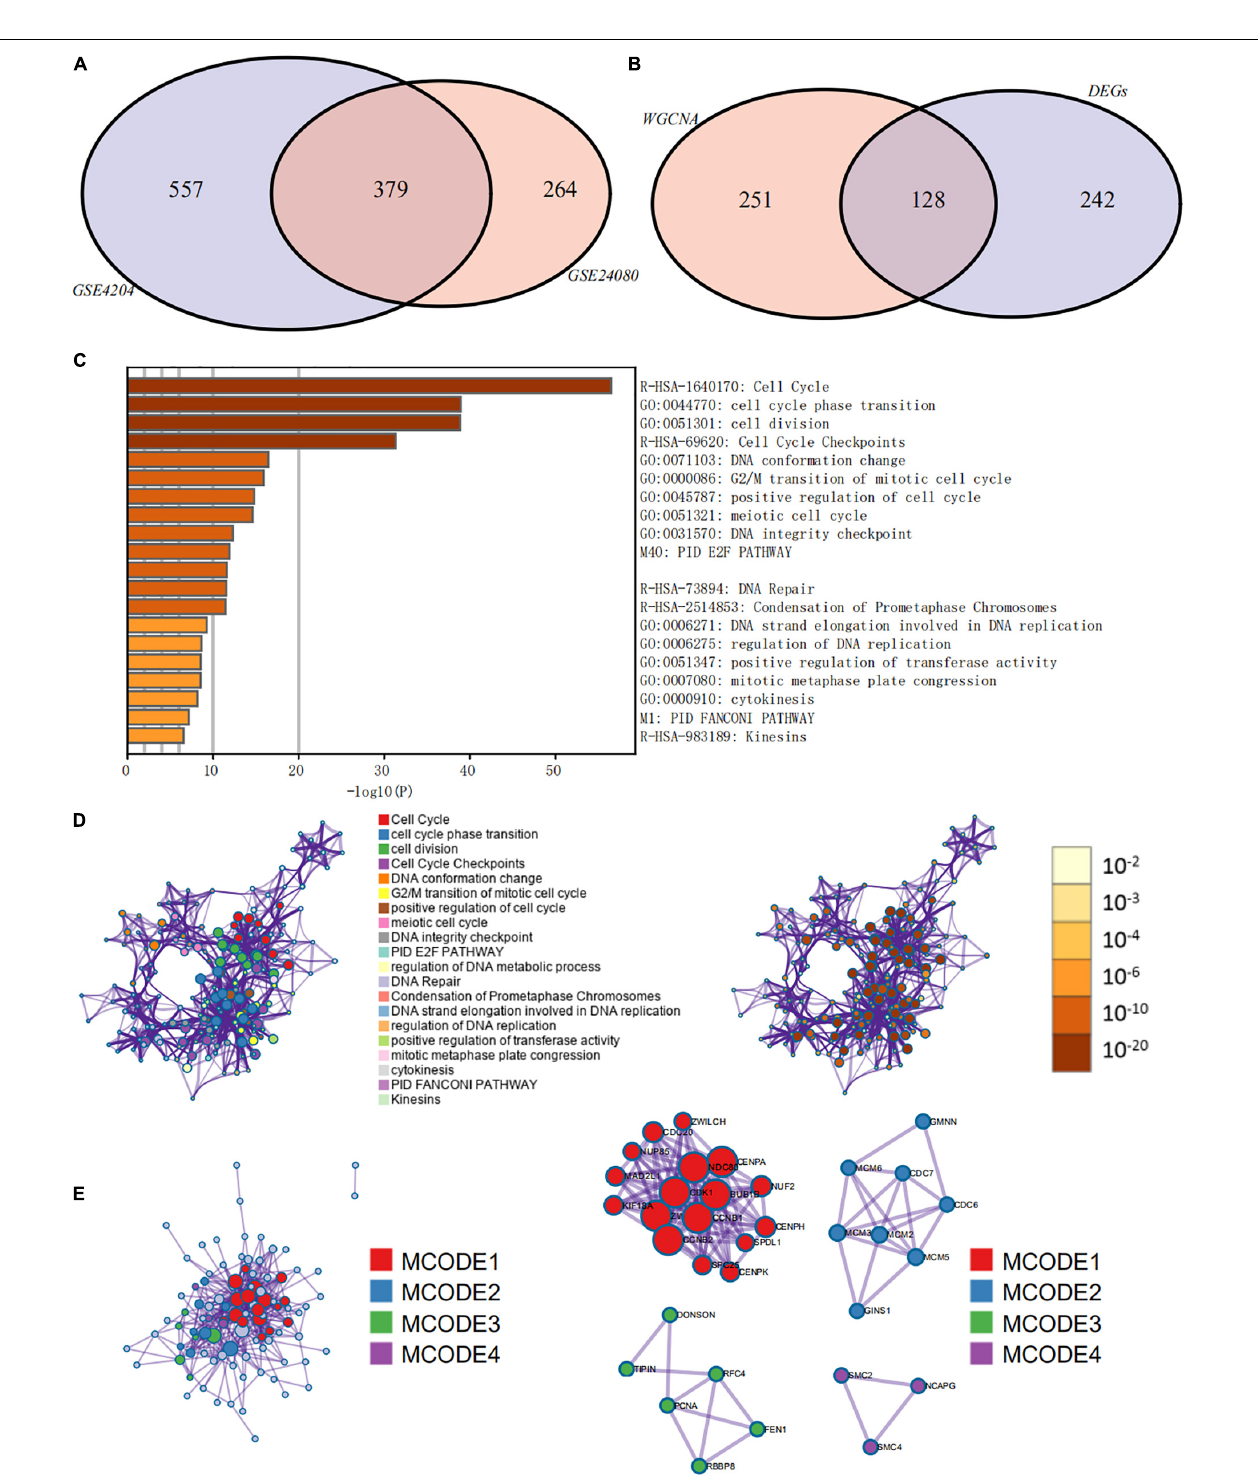
FIGURE 7 | Functional annotation and pathway enrichment analysis of key prognostic genes that were identified by weighted gene co-expression network analysis (WGCNA) and differential expression analysis. (A) Venn diagram of genes identified by WGCNA in the GSE24080 and GSE4204 cohorts. (B) Venn diagram of genes identified by WGCNA and differential expression analysis. (C) Bar graph of enriched terms of stemness-related genes, colored by P -values. (D) Network of enriched terms: (left panel) colored by cluster ID, where nodes that share the same cluster ID are typically close to each other; (right panel) colored by P -value, where terms containing more genes tend to have more significant P -values. (E) Protein–protein interaction network and molecular complex detection components identified in the gene lists of the 127 stemness-related signatures.